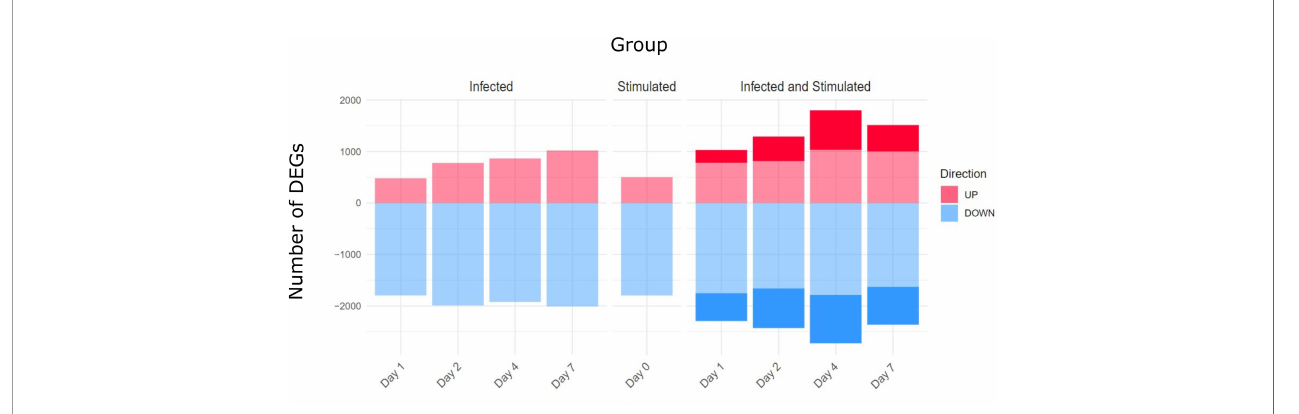
FIGURE 4 | Differentially Expressed genes (DEGs) for comparison and Time point. Three main comparisons against baseline controls were de fi ned: infected samples, stimulated samples and infected and stimulated samples. Differentially Expressed Genes (DEGs) were obtained using the DESeq2 package and establishing thresholds of FDR < 0.05 and absolute logFC > 0.5. The stimulation of spleens from infected mice led to a higher number of DEGs compared to only infected or only stimulated spleens (number of speci fi c genes highlighted in the fi